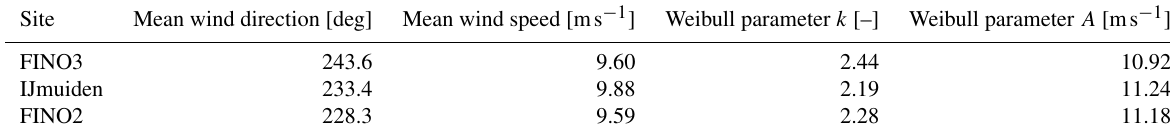
Table 1. Derived statistics for wind direction and wind speed distributions for the three datasets of site